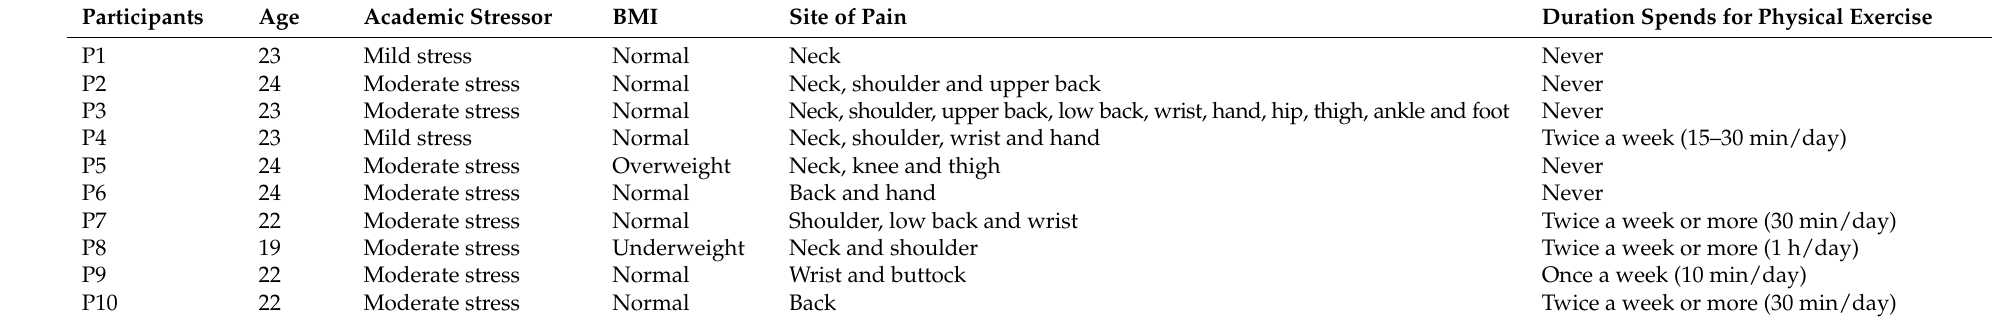
Table 3. Demographic characteristics of participants.